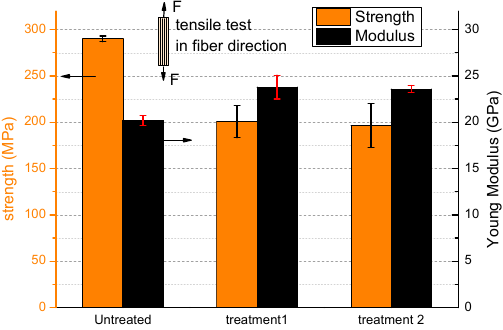
Figure 5. Influence of FA treatments on the tensile properties of composites in fiber direction (error bars indicate standard deviation).